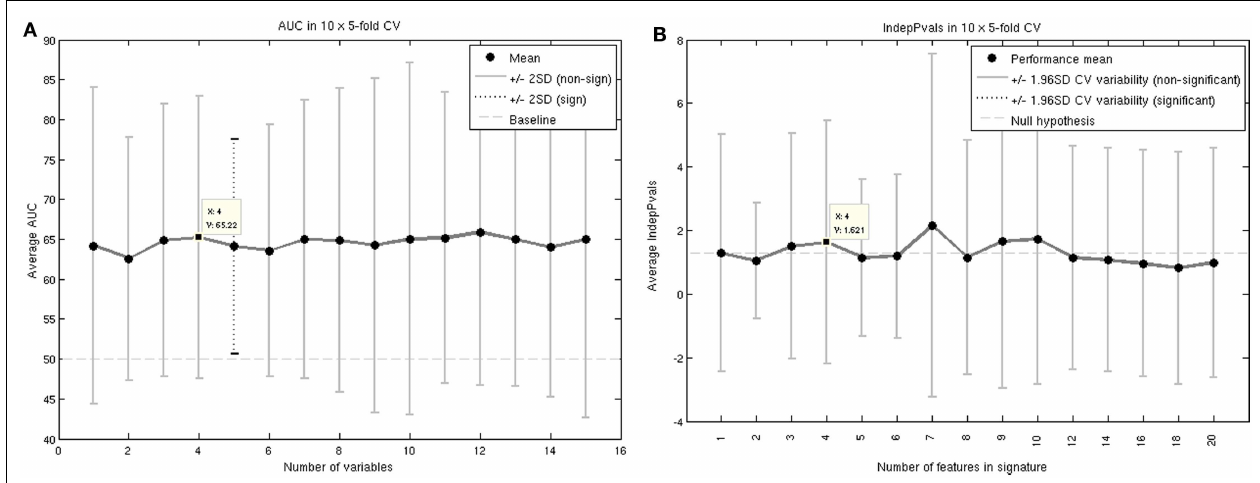
FIGURE 1 |AUC (A) and independence to clinical covariates p-values (B) for the highest performing genetic signature .